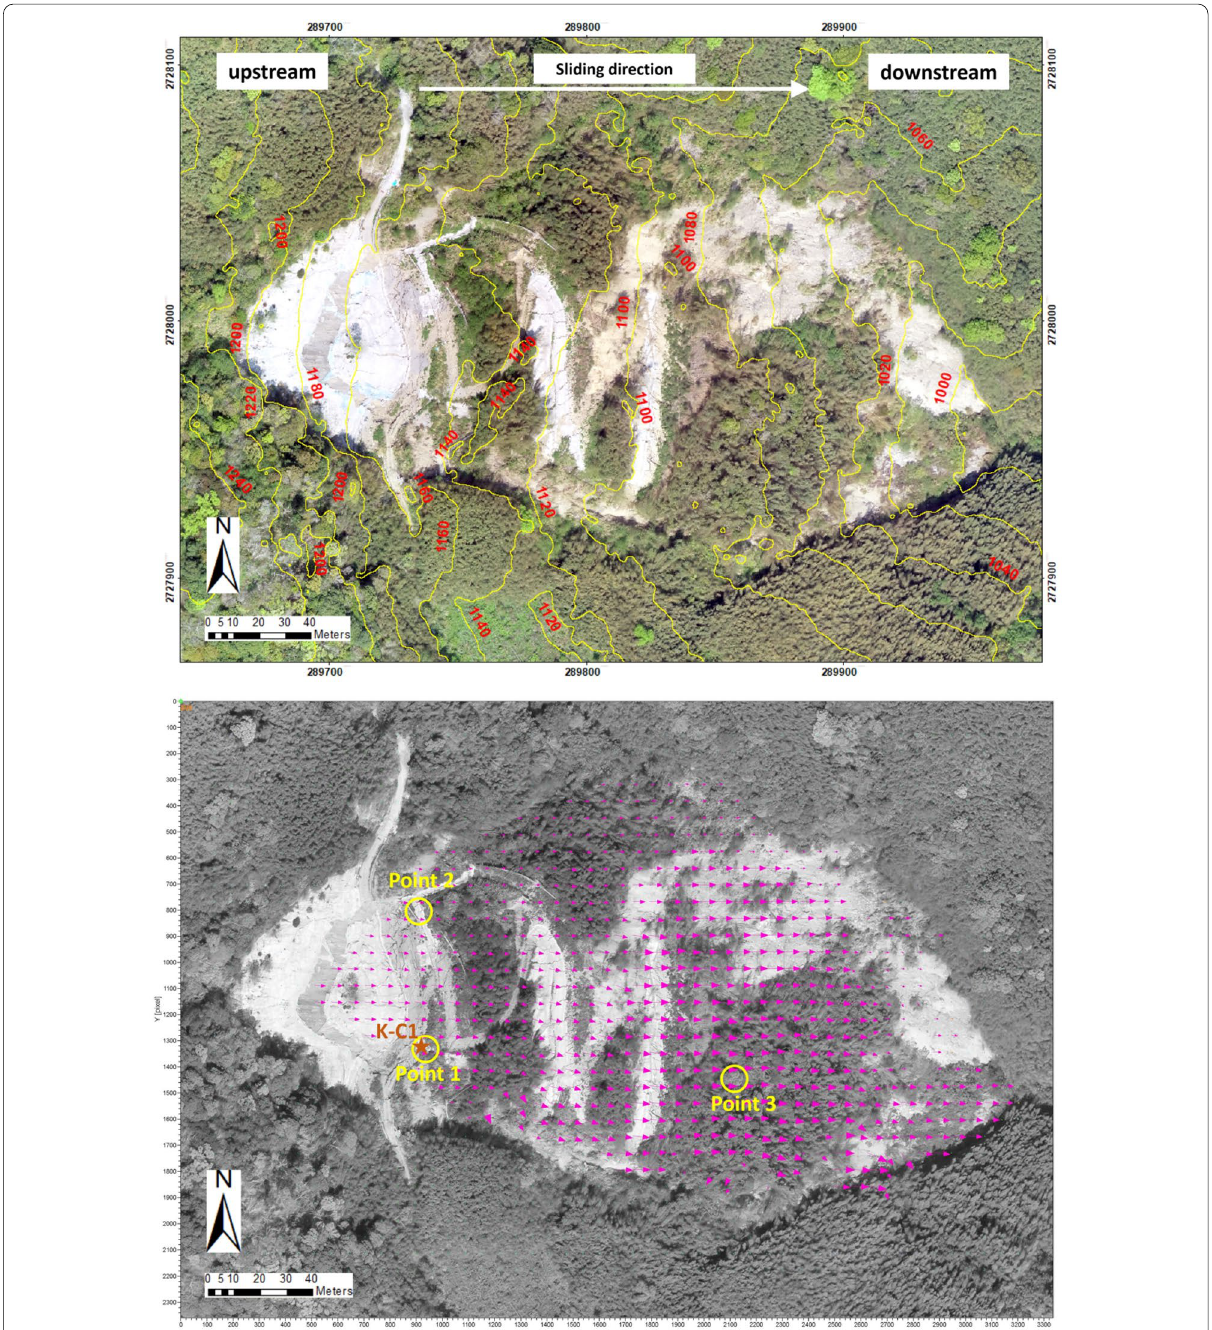
Fig. 13 PIV displacement analysis results for orthomosaics captured on February 23 and